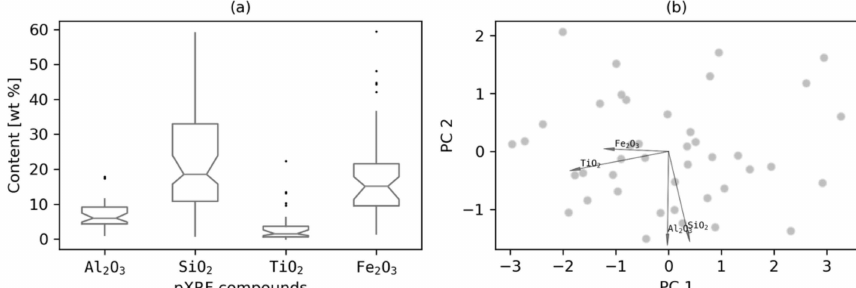
Figure 13. ( a ) Boxplot distribution of pXRF measurements of the major compounds, with black dots represent outliers. ( b ) Biplot of the first two principal components, with PCA scores as grey dots, after transformation of the four selected compounds (rays represent measured pXRF compounds), that describe the outcrop’s major elemental